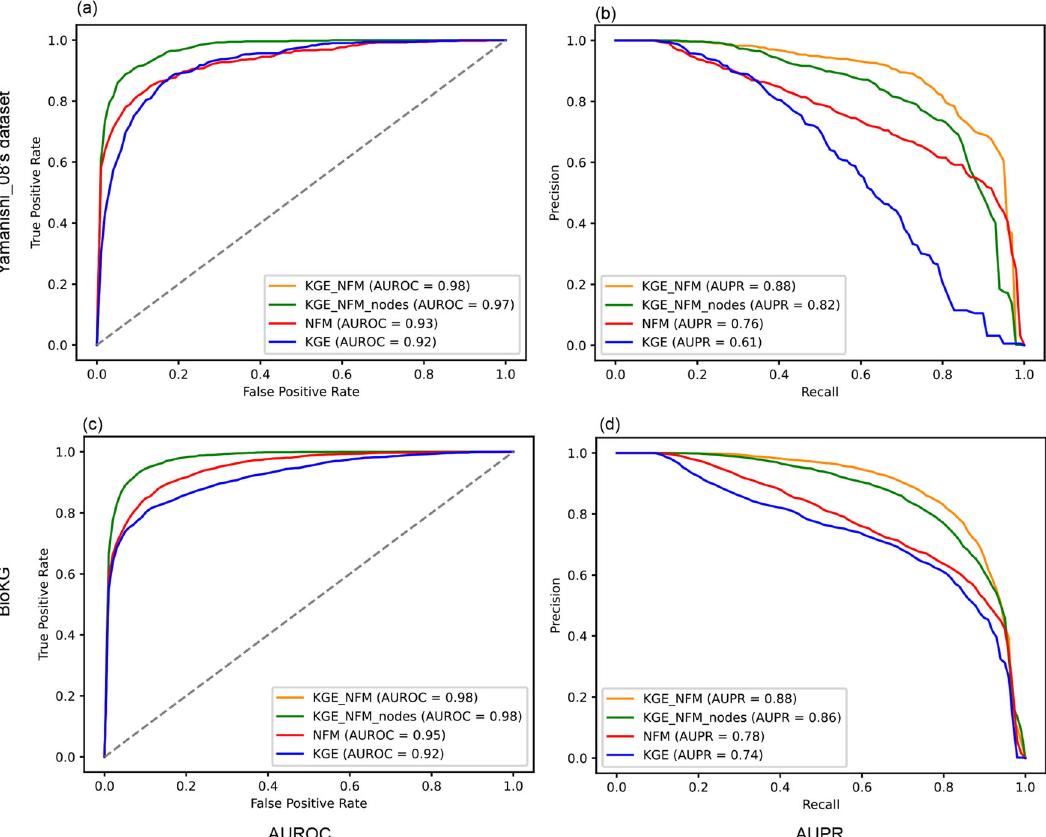
Fig. 4 Impact of each component in the KGE_NFM framework on predictive performance in the scenario of the warm start in the unbalanced situation. a and b represent the ROC and PR curves on the Yamanishi_08 ’ s dataset, respectively. b and d represent the ROC and PR curves on the BioKG dataset, respectively. Speci fi cally, KGE_NFM_nodes means that the KGE_NFM framework does not incorporate the information of traditional